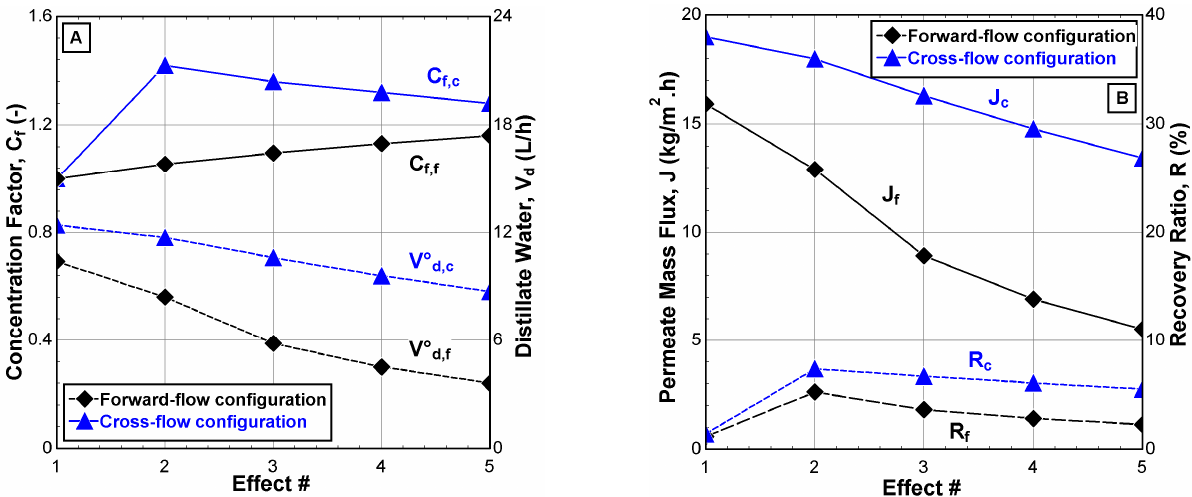
. . v H 1 = 900 L/h, T H 1 = 75 ◦ C, v C 1 = 405